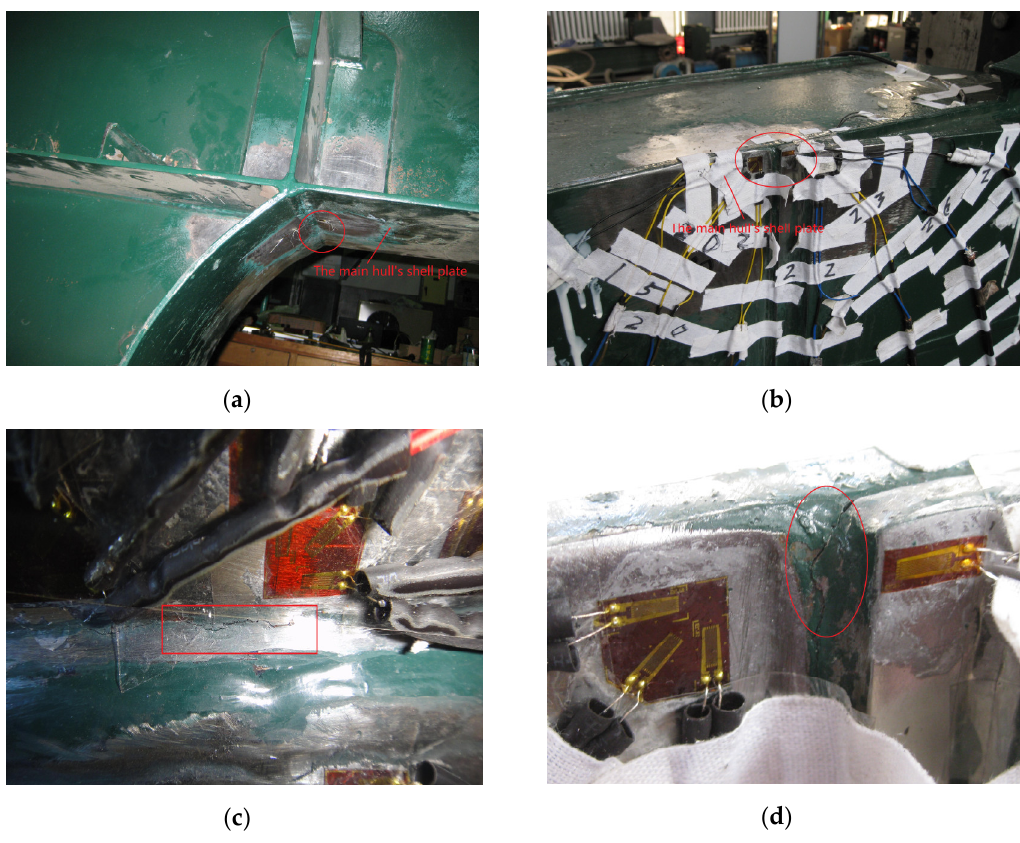
Figure 7. The damage graphs of fatigue test models as follows: ( a ) Damaged position of model 1; ( b )